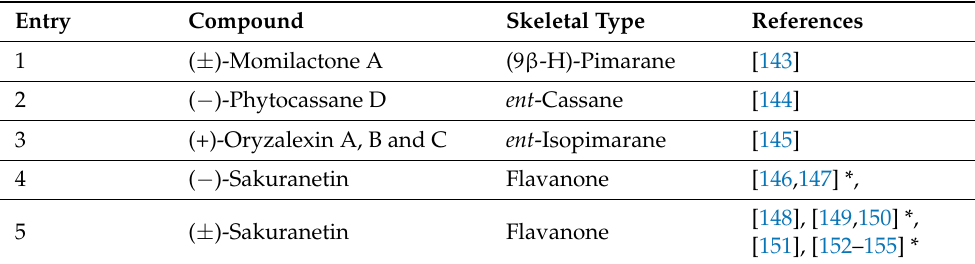
Table 3. Rice phytoalexin chemical synthesis.